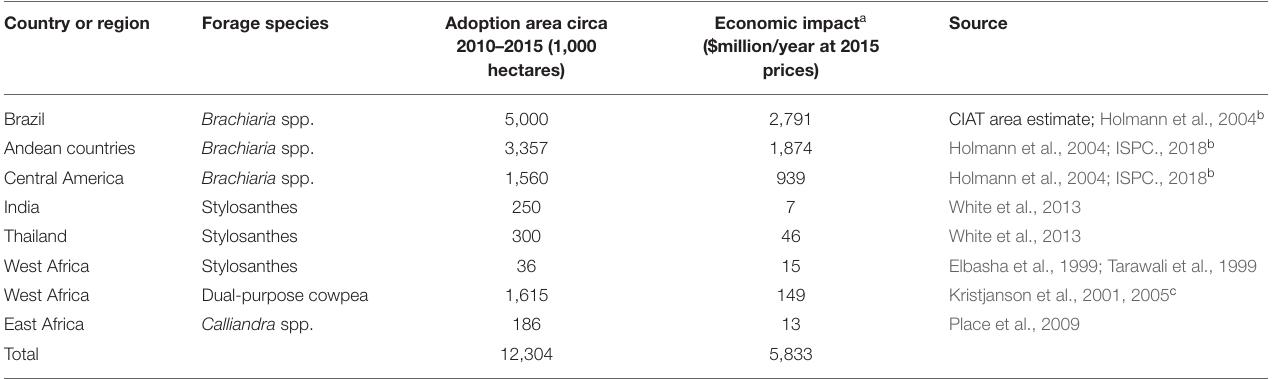
TABLE 4 | Adoption and impact of CGIAR-related improved forage crop varieties in developing countries. Country or